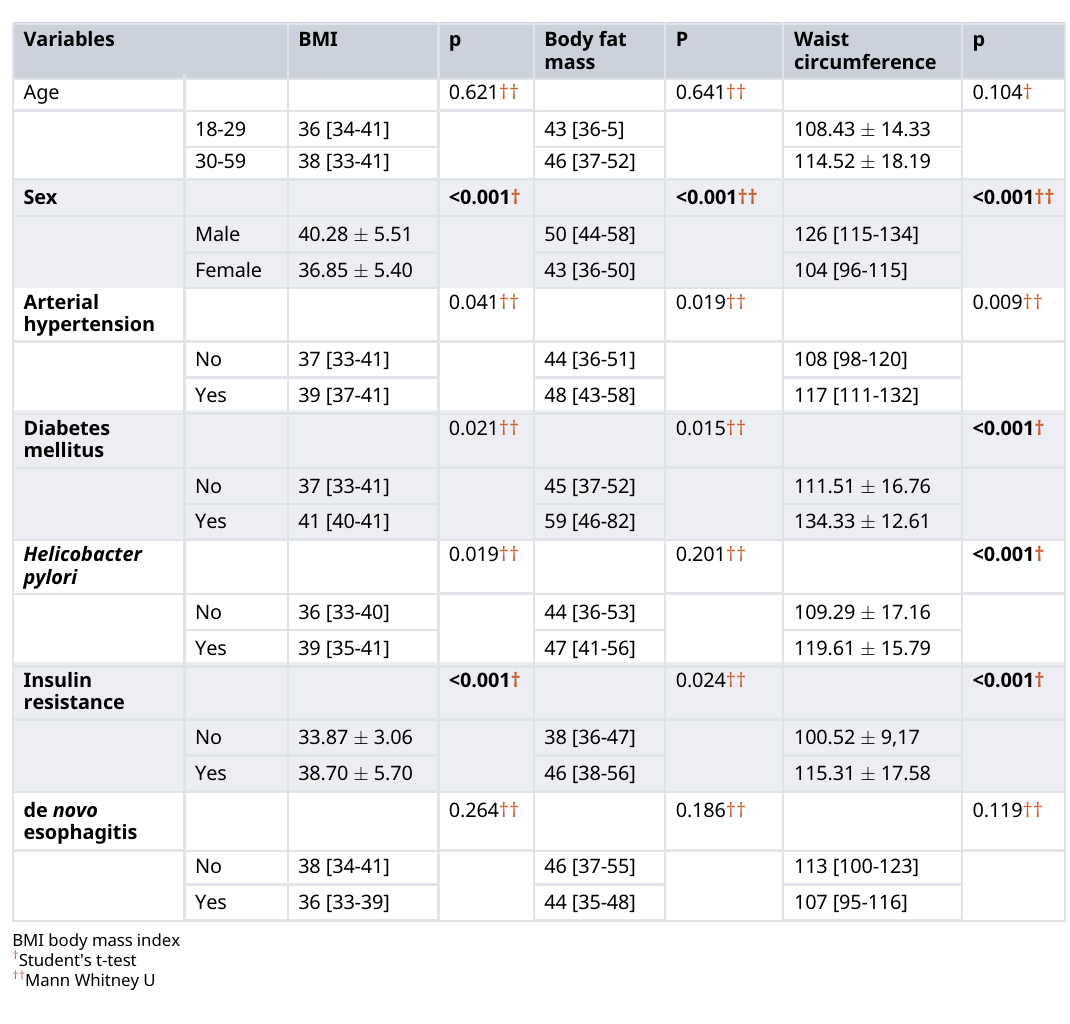
Table 2. Body mass index, body fat percentage and waist circumference according to clinic and laboratory characteristics (n=106).